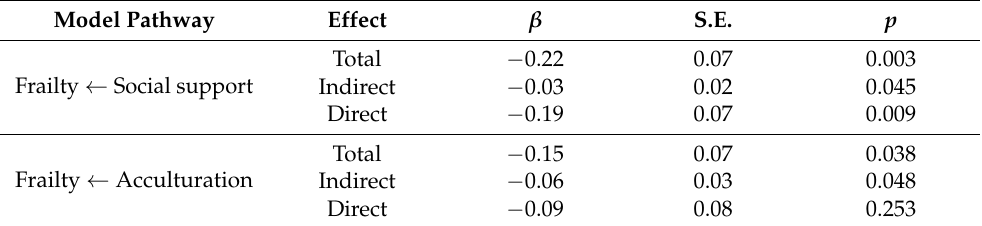
Table 4. The mediating effect of health literacy.